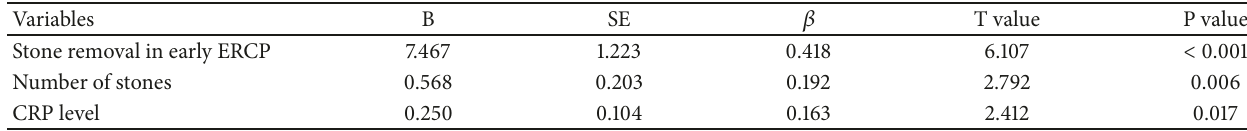
Table 6: Stepwise multiple linear regression analysis for variables associated with hospitalization